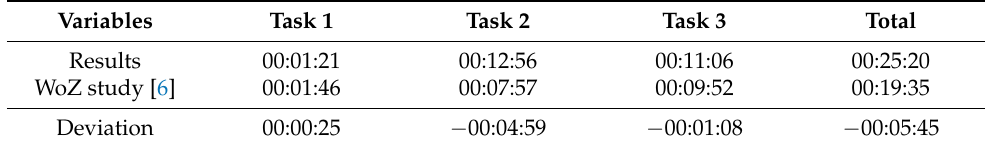
Table 4. Comparison efficiency.